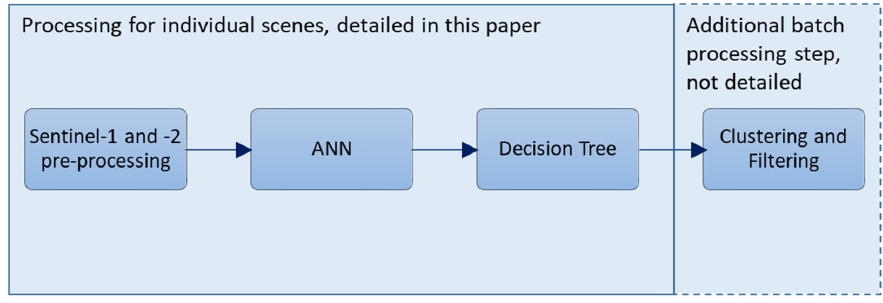
Figure 14. Flow diagram summarizing the developed classifier’s processing